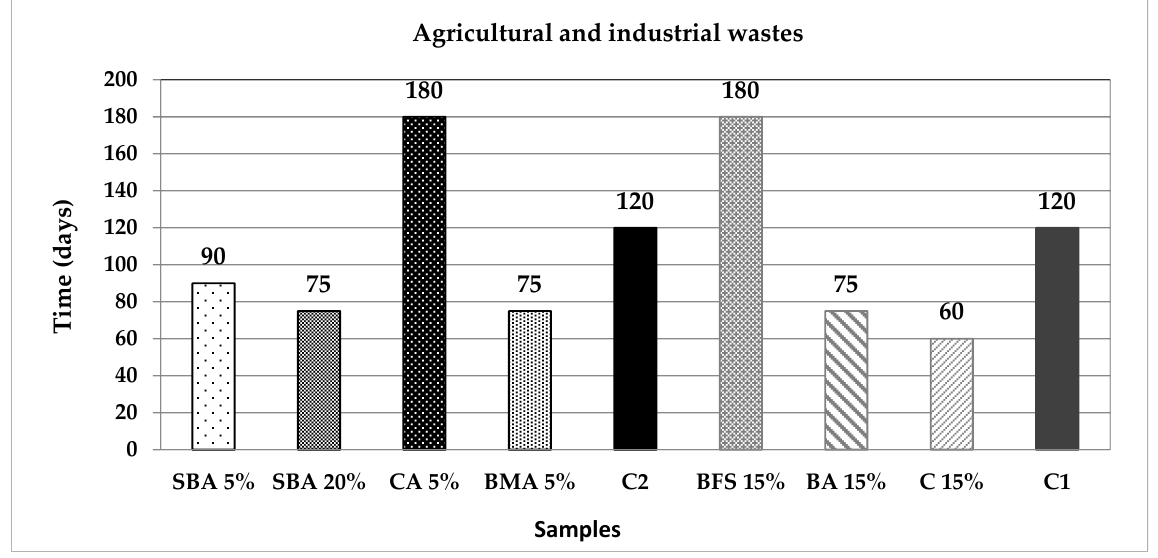
Figure 10. Advance of the carbonation front as a function of the time for the minerals and fibres group of additions.